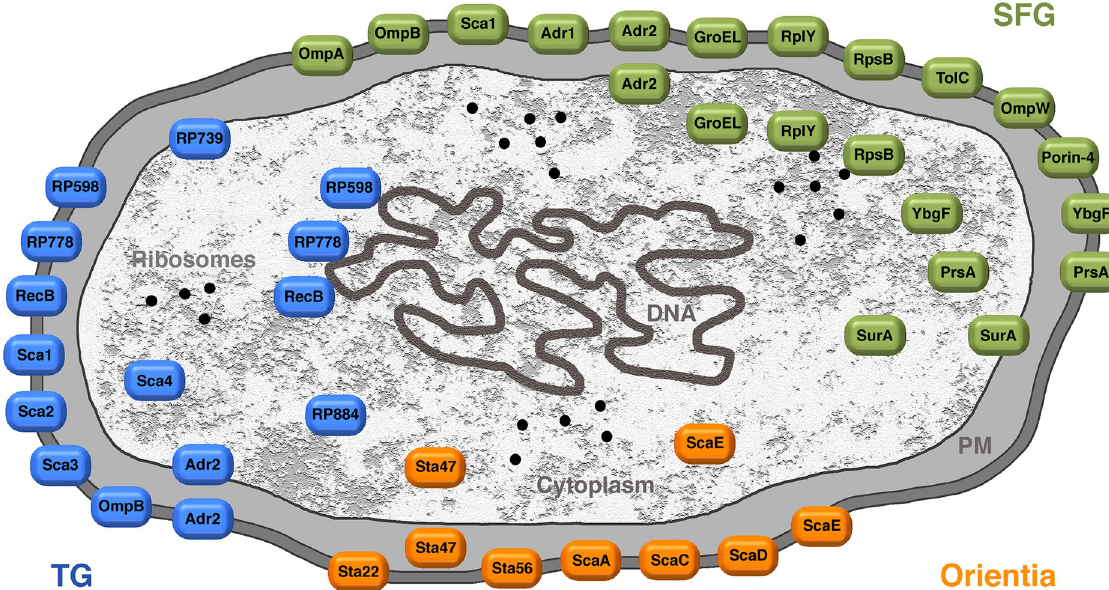
Fig 7. Overview on the antigens identified from Orientia, TG, and SFG rickettsiae and localization of these proteins. The picture provides an overview on the antigens identified from Orientia, TG, and SFG rickettsiae and their subcellular localization. PM, periplasm; SFG, spotted fever group; TG, typhus